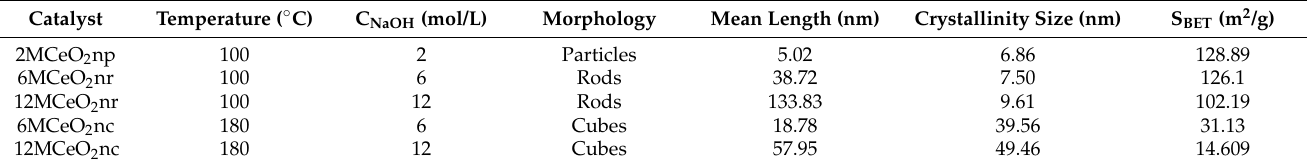
Figure 1. XRD patterns of the as-prepared CeO 2 nanomaterials. Table 1. Synthesis conditions and physicochemical characteristics of the as-prepared CeO 2 nano- materials with different morphologies.